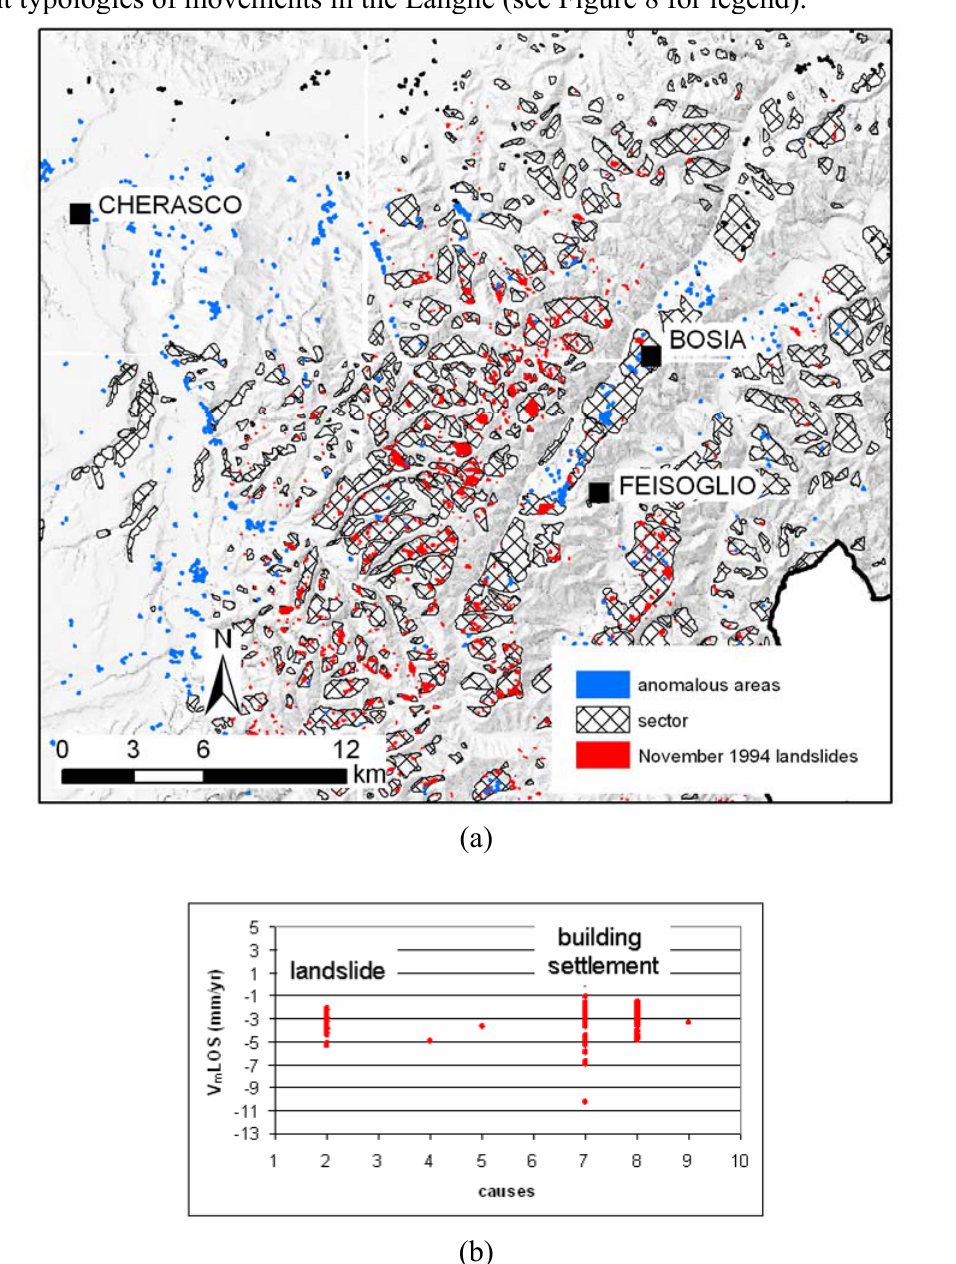
Figure 9. (a) Landslides in the Langhe area. (b) Comparison between the VLOS and the different typologies of movements in the Langhe (see Figure 8 for